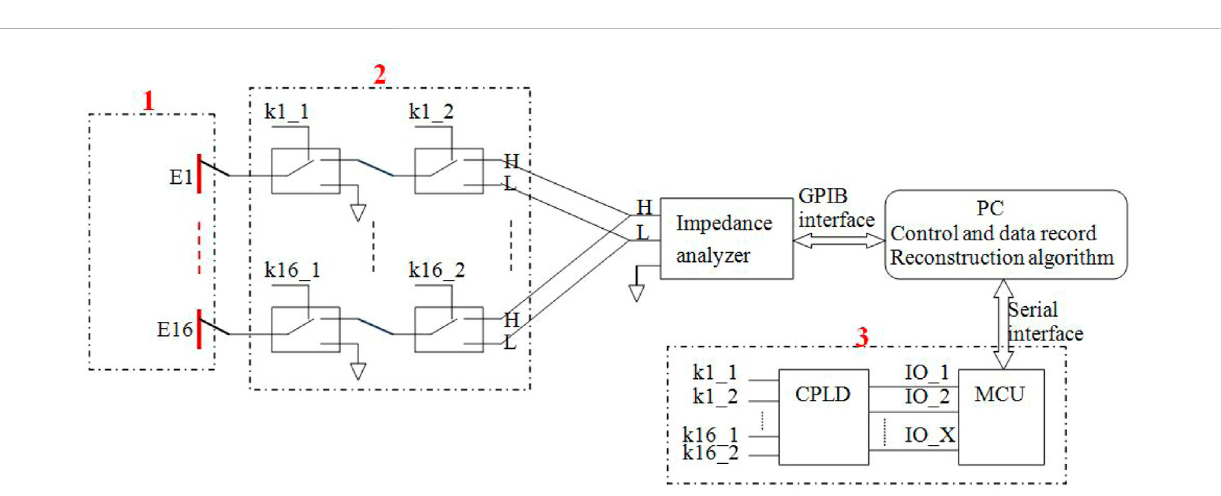
FIGURE 2 Schematic diagram of the electrical connection of the measuring system. The dashed box 1: 16 electrodes. The dashed box 2: The electrical connection of relay circuitry. The dashed box 3: The electrical connection of control